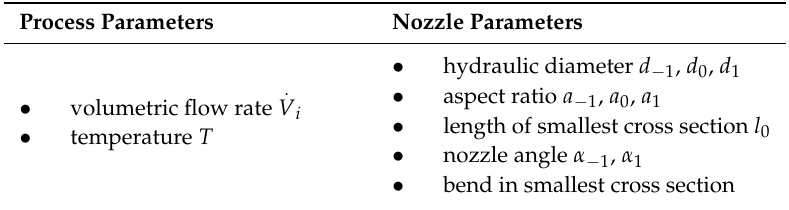
Table 1. All adjustable process inputs with potential influence on turbulent bubble